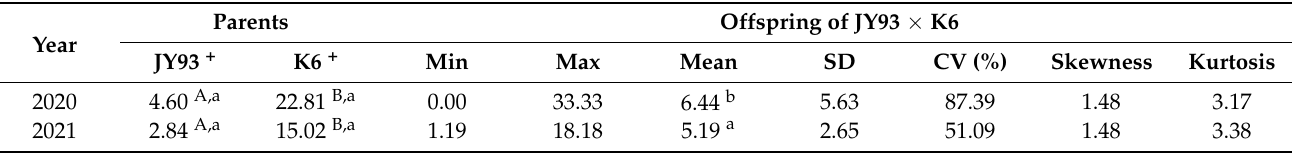
Table 2. Total SNP numbers and linkage distances of chromosomes in F 2 population.